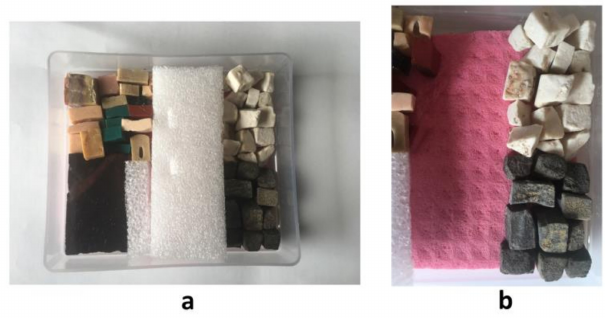
Figure 21. Mosaic mock-up: ( a ) top view, ( b ) detail of the sponge background.